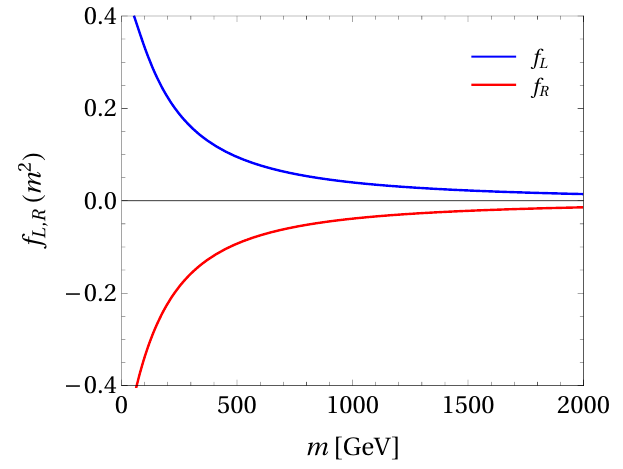
(cid:0) (cid:1) and m 2